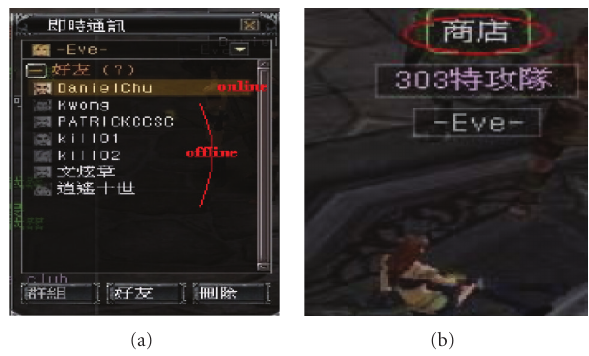
Figure 2: (a) People awareness: who’s online?; (b) people awareness: where is the player and who is